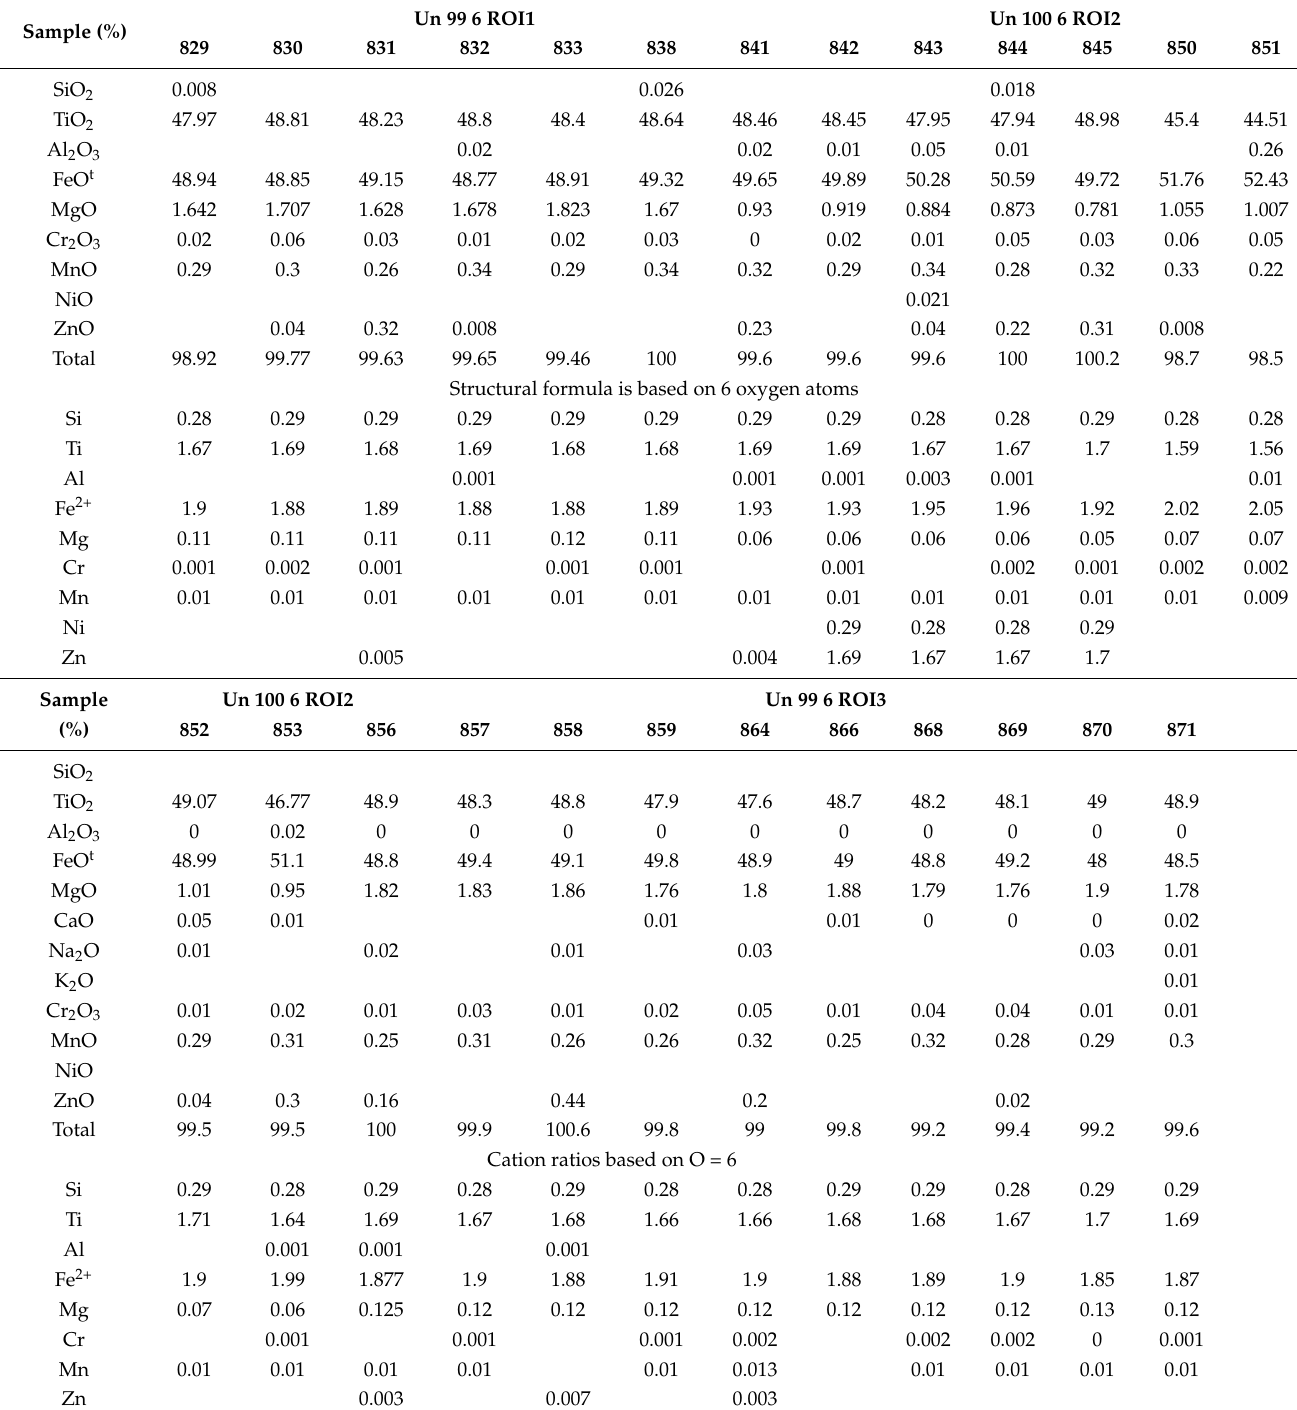
Table 3. Representative electron microprobe analyses of ilmenite from the Abu Ghalaga mine,